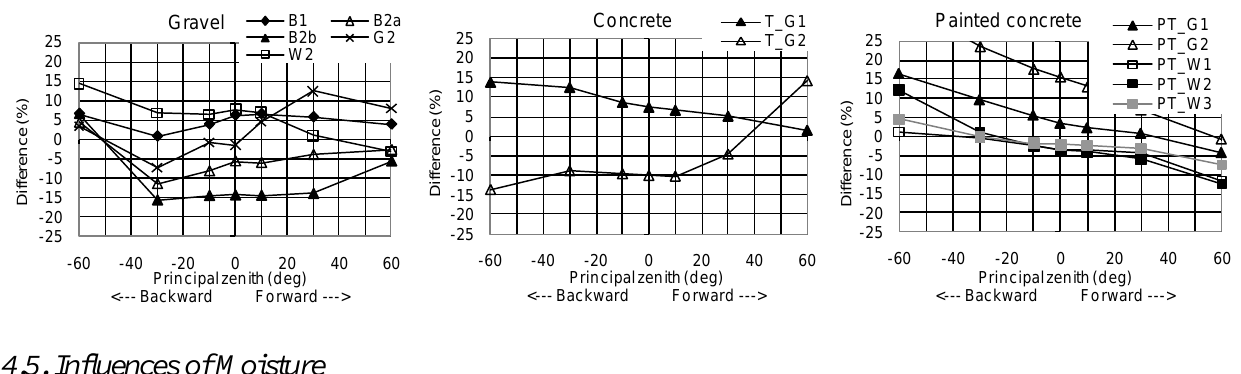
Figure 10. Differences of reflectance factors measured in spring and autumn at the principal plane on PAN channel (Equation 7, spring as reference). Left: gravel; center: concrete; and, right: painted